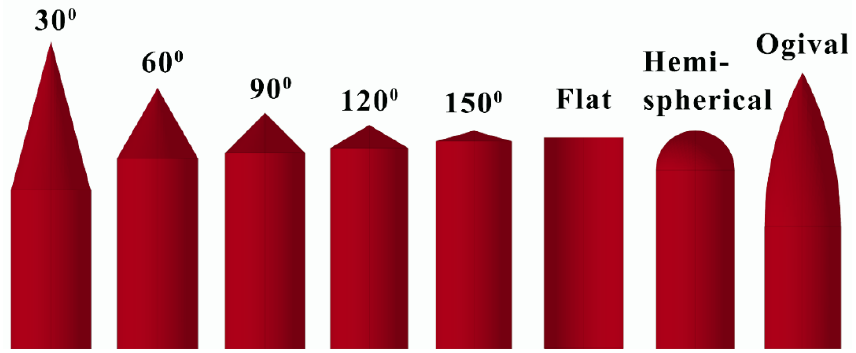
Figure 1. The projectile nose shapes in the experimental and numerical tests. Table 2. The geometrical parameters of the projectiles.